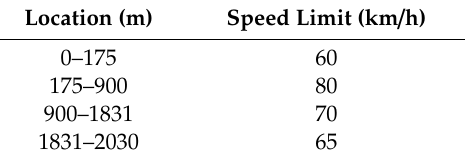
Table 5. Speed-limit